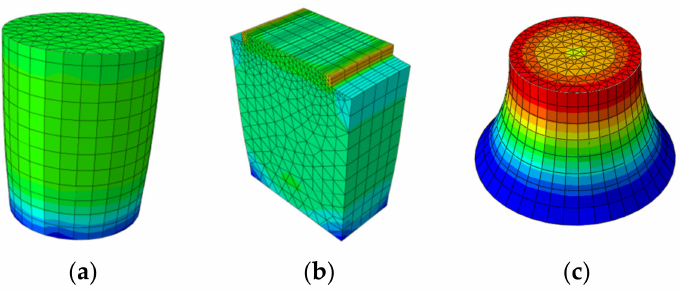
Figure 4. The stress states of middle cross sections: ( a ) cylindrical geometry; ( b ) double-notched geometry; and ( c ) dog-bone